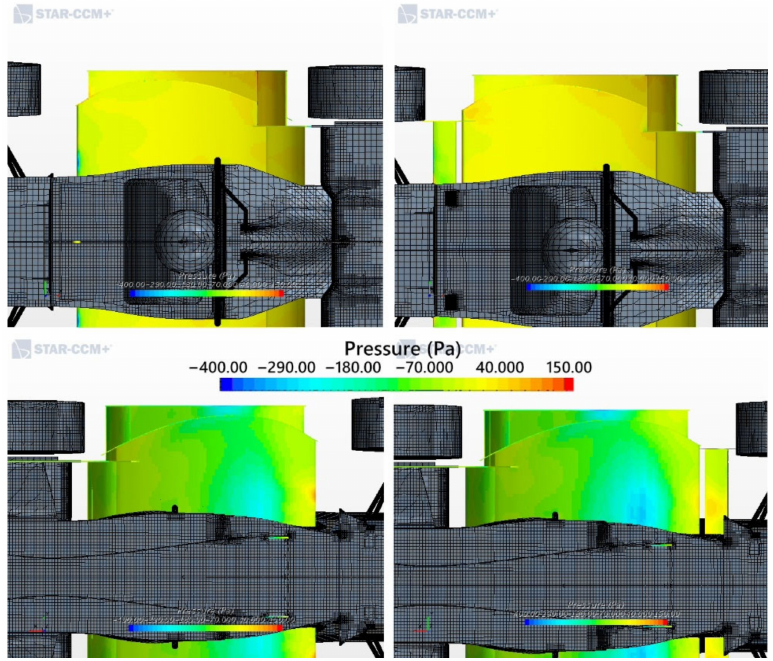
Figure 22. Comparison of velocity at 400 mm offset section plane of vehicle longitudinal symmetrical plane. ( a ) Original condition, the velocity at the front upper section of side wing is lower than 4 m/s; ( b ) the velocity above and below the side wing increases significantly after implementing the shutters.